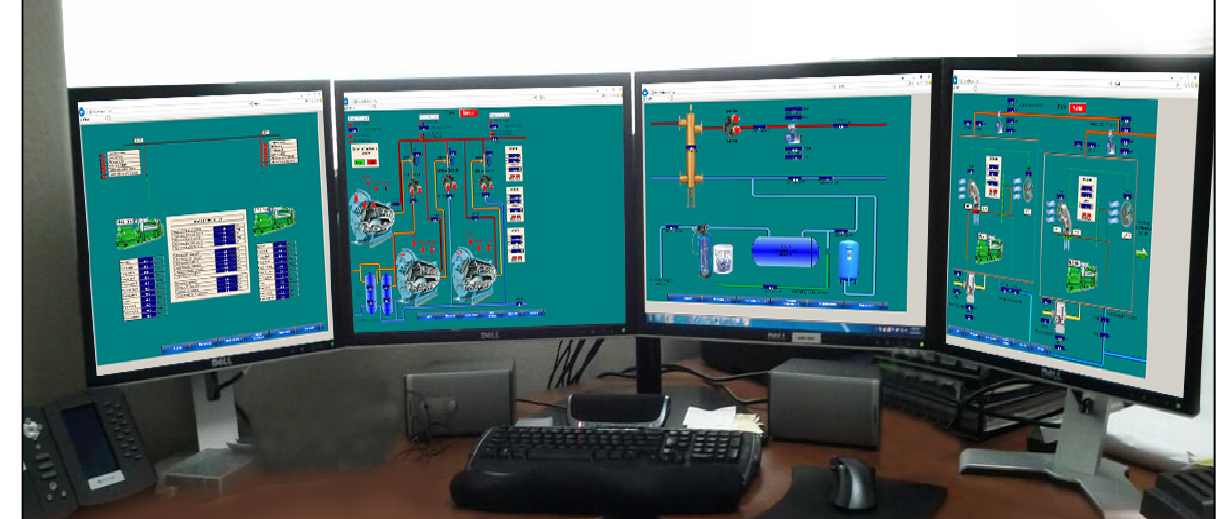
Figure 6. The dashboards for the students’ house and cogeneration plant.